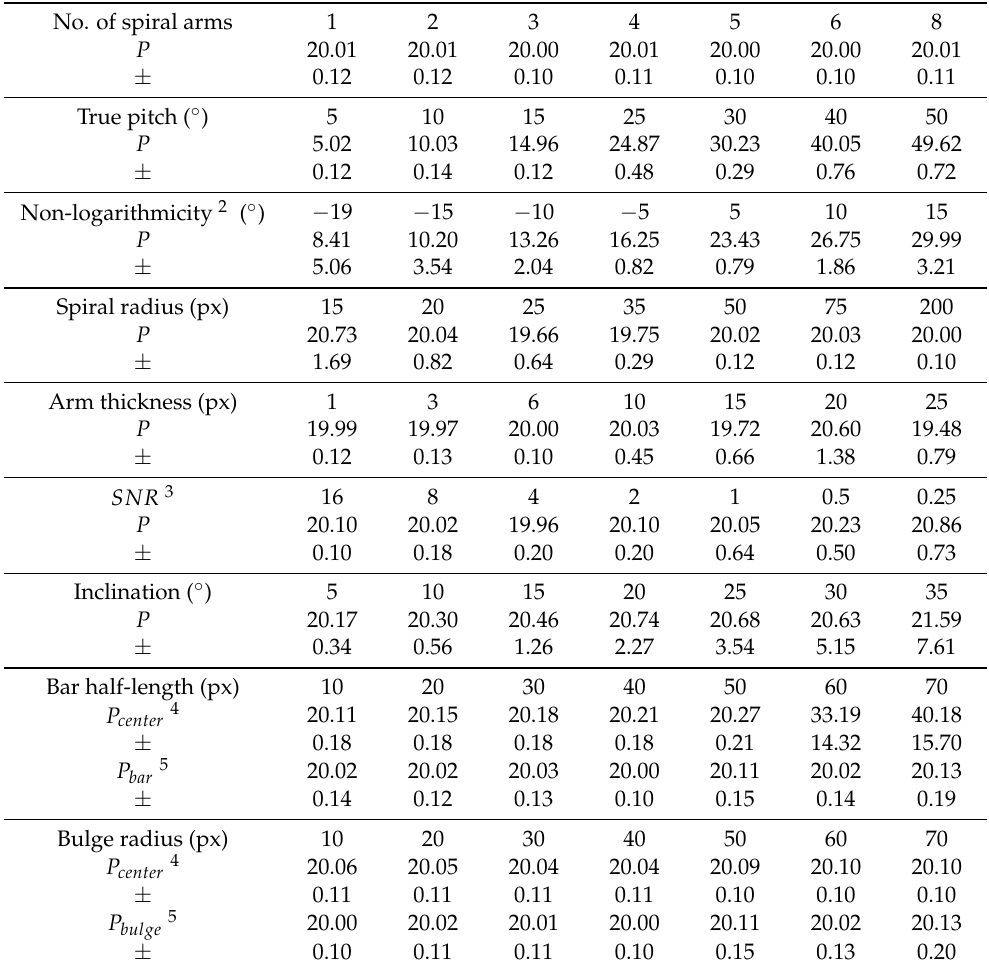
Table 1. Test results for variations of the ideal 1 synthetic spiral. Each triplet of rows shows a variation on one of the spiral’s properties. For each triplet, the top row shows the value of the quantity being varied, the middle row shows the measured pitch in degrees, and the bottom row shows the measurement uncertainty. For Spirality’s input parameters, we used the so-called optimal inputs described in Table